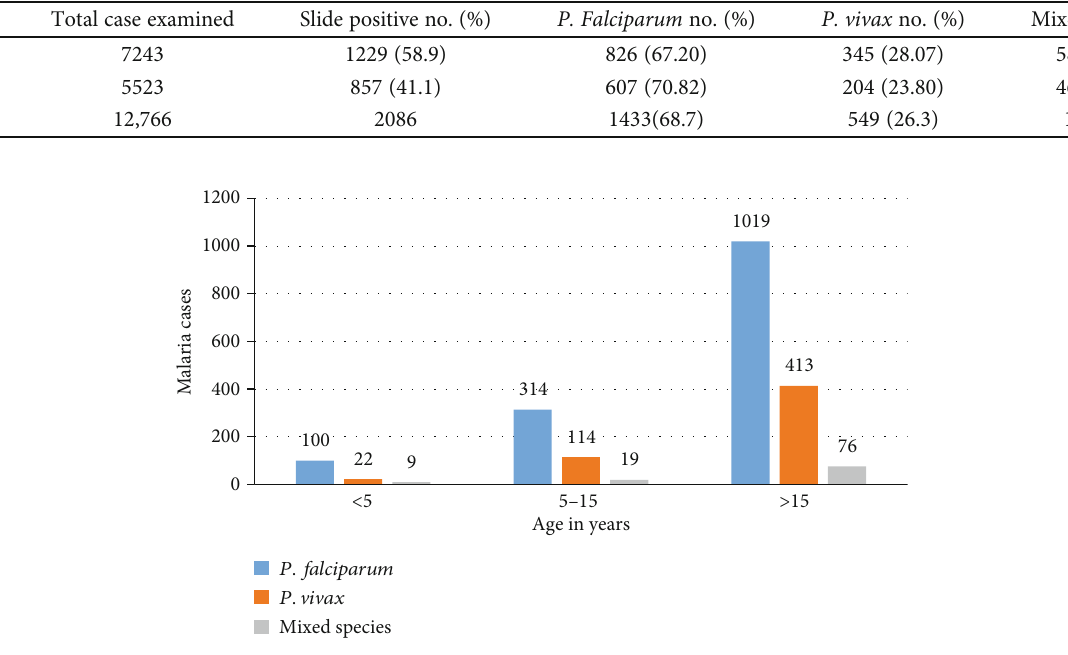
Figure 2: Trends of malaria species across age groups in at Dembecha Health Center, northwest Ethiopia